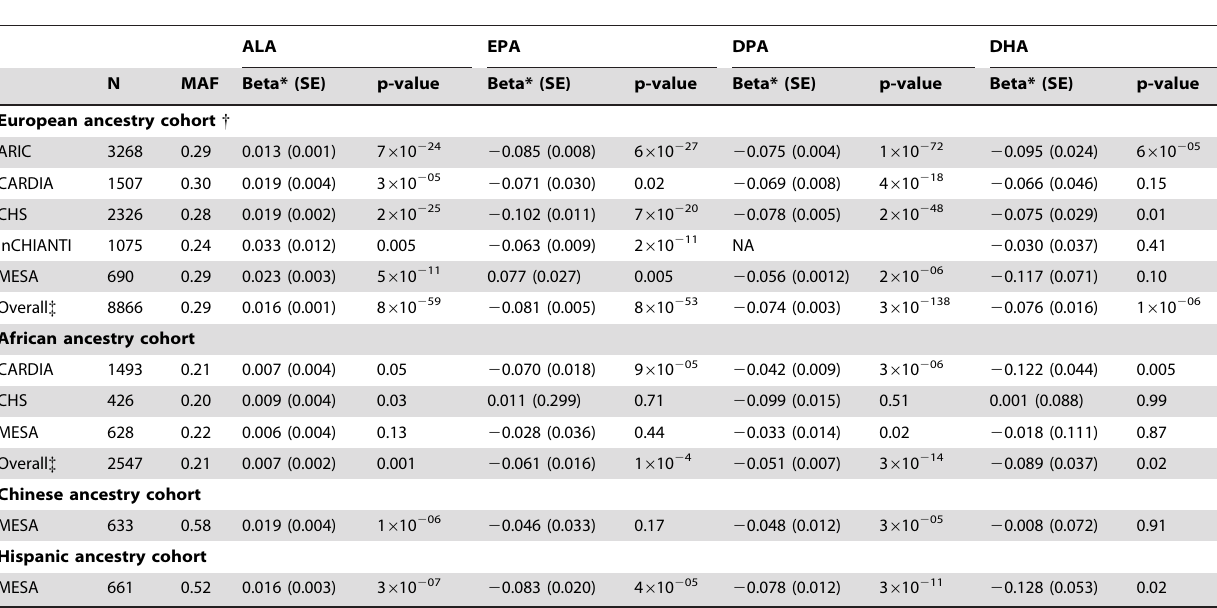
Table 3. Associations of rs174548 (G allele) with n-3 polyunsaturated fatty acids in samples of different